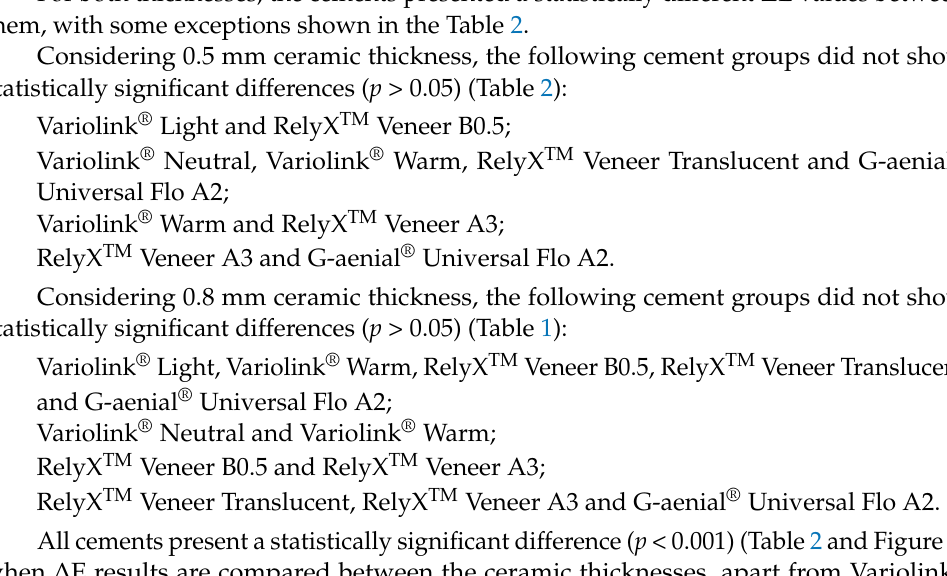
For both thicknesses, the cements presented a statistically different  E values be-